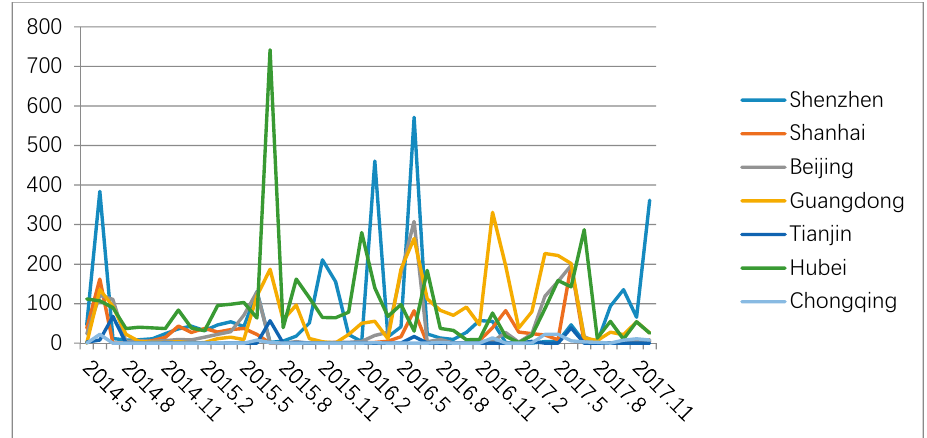
Figure 5. Monthly trade turnover in seven-pilot carbon trade markets.